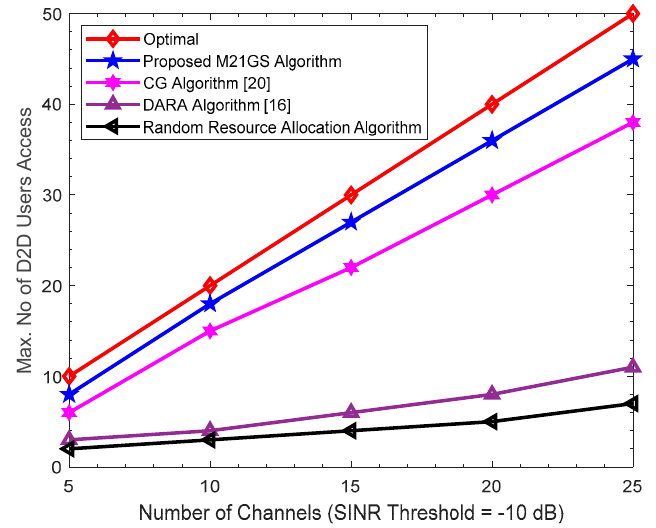
Figure 3. Comparison of the maximum allowable number of D2D users of the algorithms.